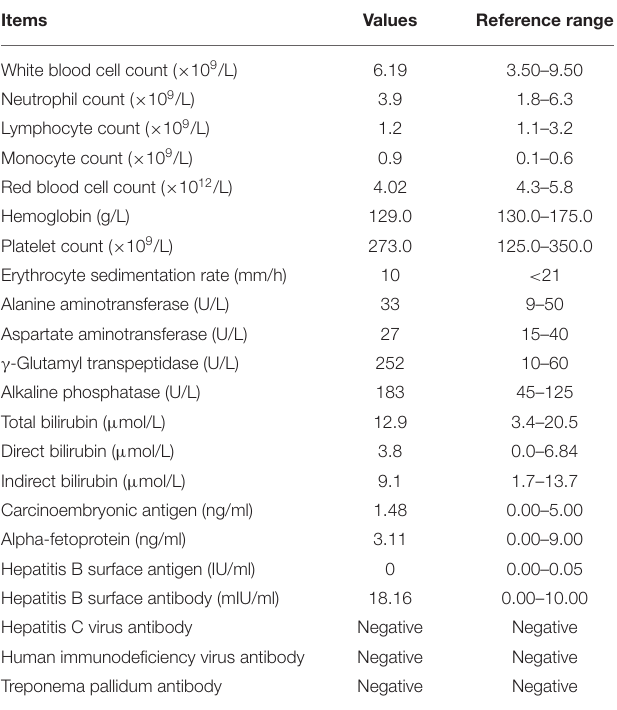
TABLE 1 | Laboratory examination results of the patient. TABLE 2 | Result of mNGS of the spinal surgical resection